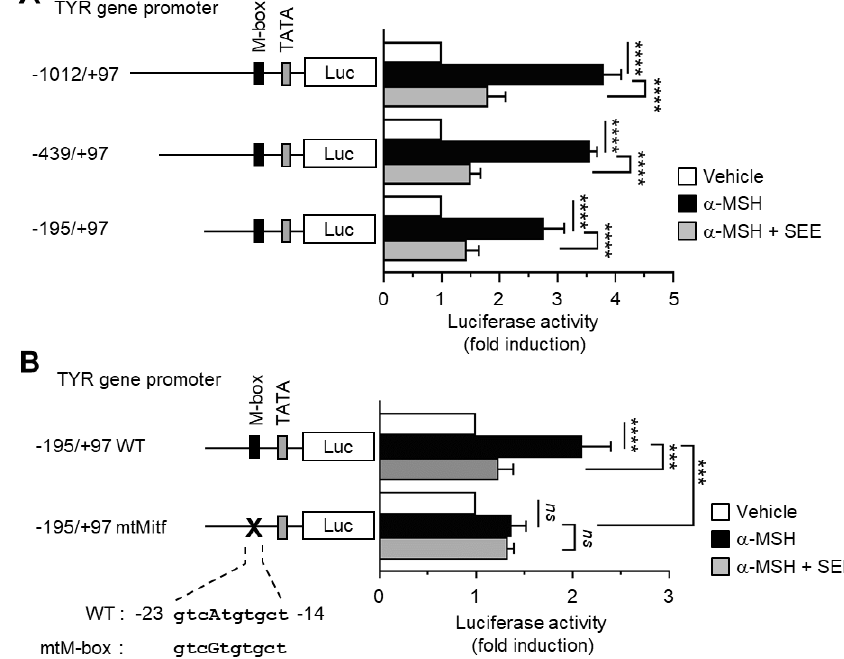
Figure 2. Effect of SEE on the inhibition of α -MSH-induced TYR promoter activity. ( A ) B16F10 cells were transfected with 0.2 μg of a series of 5′ -deletion constructs of the TYR gene promoter reporter plasmids, or ( B ) transfected with 0.2 µ g of a wild-type (WT) or site-specific mutant for M-box (mtM-box), derived from the − 195/+97 construct. Forty-eight hours later, the cells were treated with either vehicle (DMSO), 100 nM α -MSH, or α -MSH plus 50 µ g/mL SEE for 8 h, and luciferase activities were measured. The data shown represent the mean ± SD ( n = 3). **** p < 0.0001; *** p = 0.0004; ns , not significant.